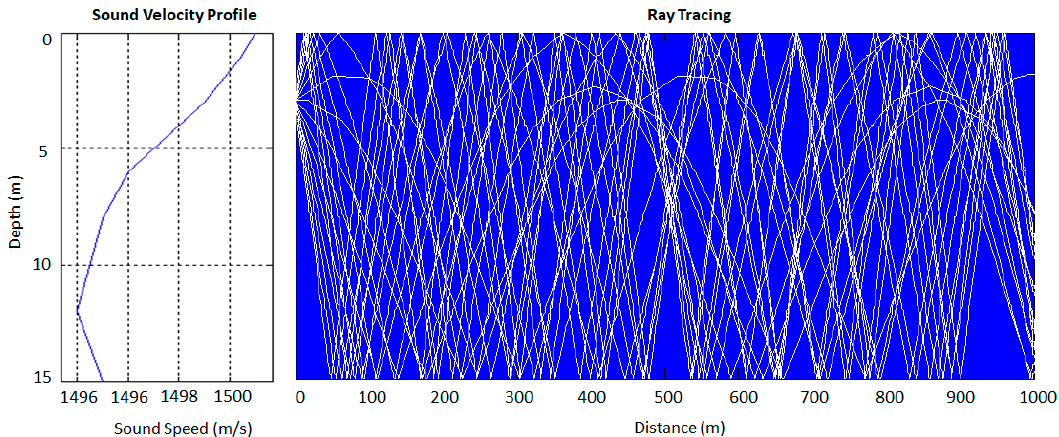
Figure 5. Modeled underwater acoustic scattering in shallow water using the ray theory for different computed sound velocity profiles in the morning ( top ) and in the afternoon ( bottom ) at the study site. Sea bottom is comprised of sand.